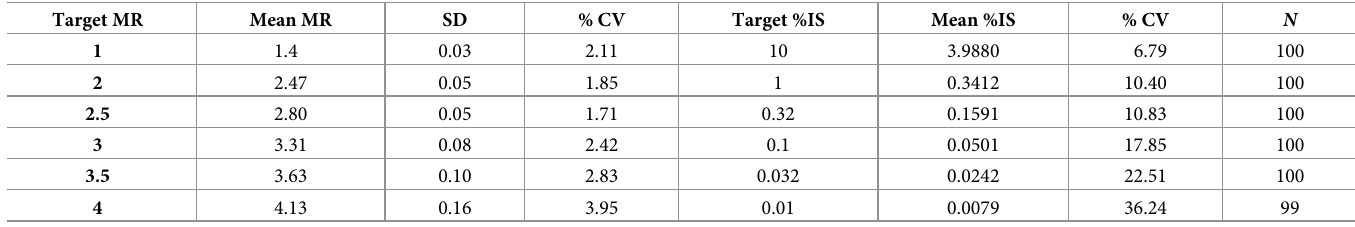
Table 2. Single-site